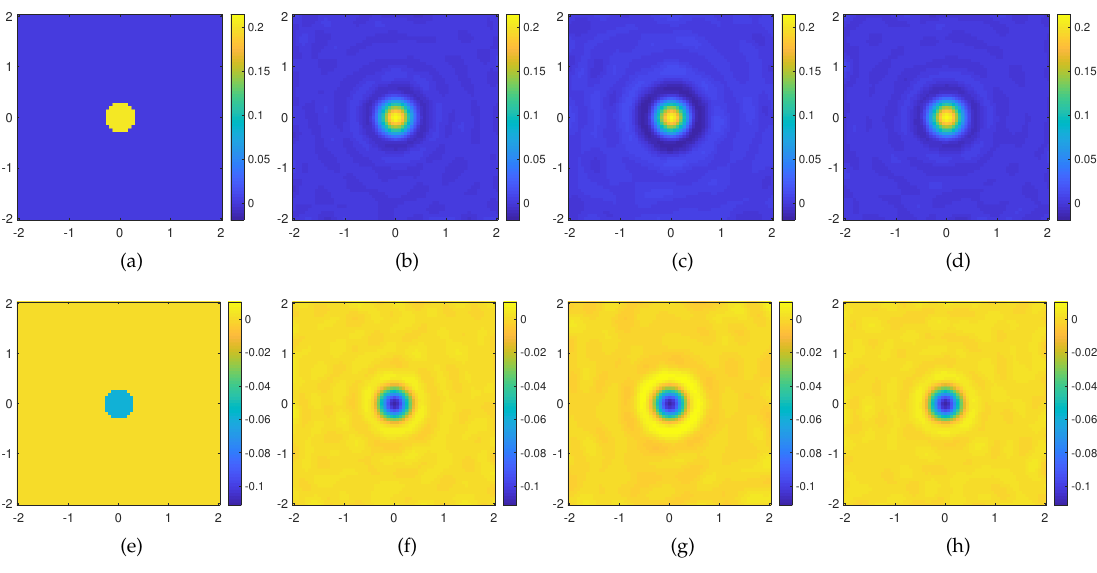
Figure 3. Reconstruction of a small weak circular scatterer through the Born approximation. ( a ) Real and ( e ) imaginary part of the actual contrast profile; ( b ) real and ( f ) imaginary part of the retrieved contrast profile for (cid:96) = 0, ± [ 1 − 18 ] , err = 0.2028 with a cutoff value in the TSVD equal to N T = 252; ( c ) real and ( g ) imaginary part of the retrieved contrast profile for (cid:96) = 0, ± [ 1 − 3 ] , err = 0.2384 with a cutoff value in the TSVD equal to N T =142; ( d ) real and ( h ) imaginary part of the retrieved contrast profile using V = M = 37 equispaced filamentary currents err = 0.2020 with a cutoff value in the TSVD equal to N T = 252. The axes of the imaging domain are expressed in background